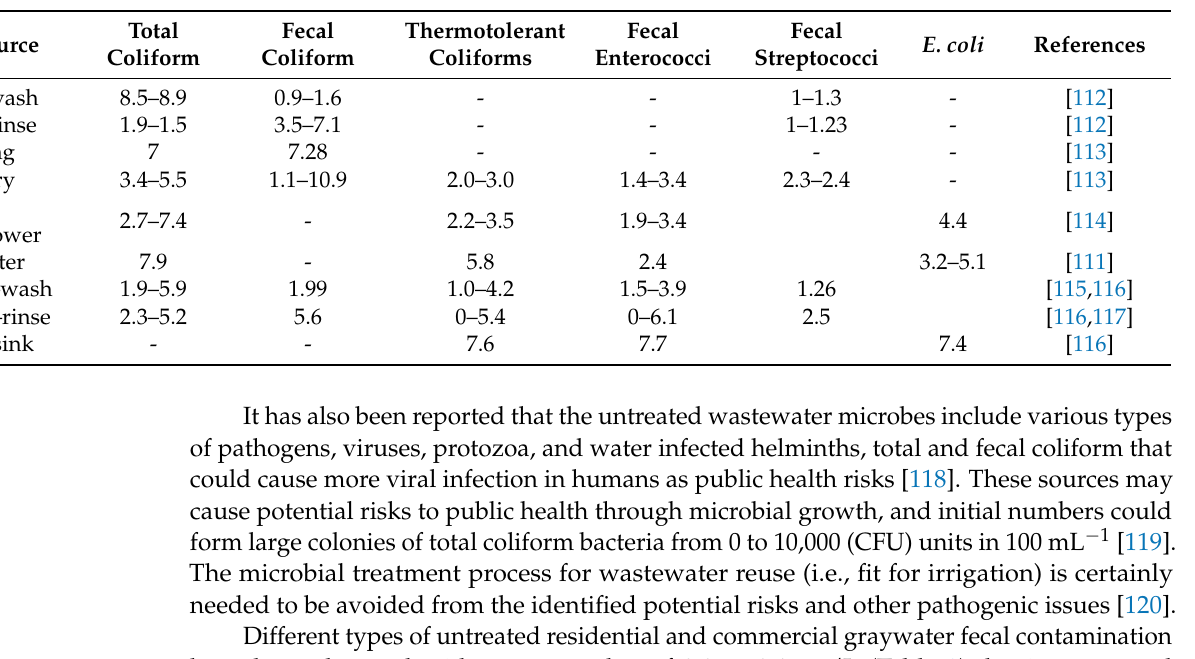
Table 8. Bacterial indications and presence of microbes in the grey wastewater (log 10 /100 mL) [110,111].